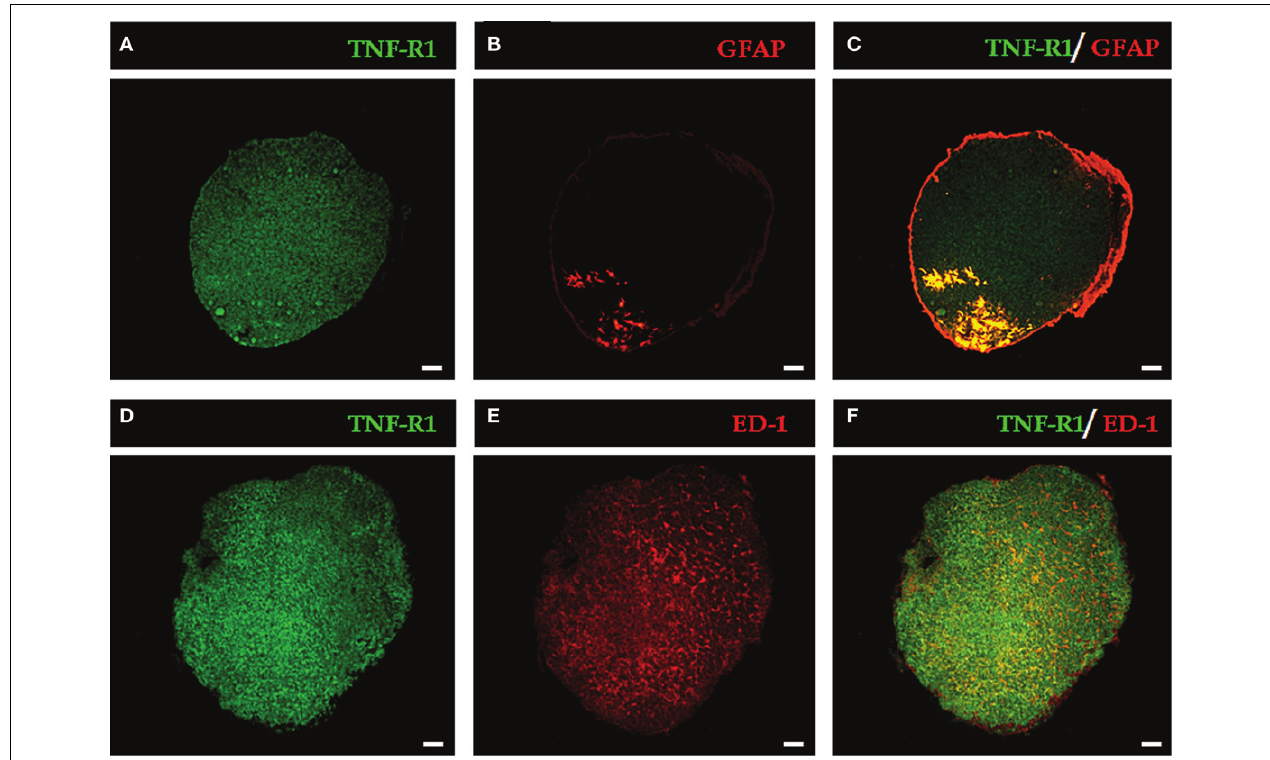
restricted to the proximal region near the pineal stalk (B) , while ED-1–positive cells are dispersed in the pineal gland (E) . In merged images, yellow indicates double labeling forTNF-R1 and GFAP (C) or ED-1-positive cells (F) . Scale bar = 200 μ